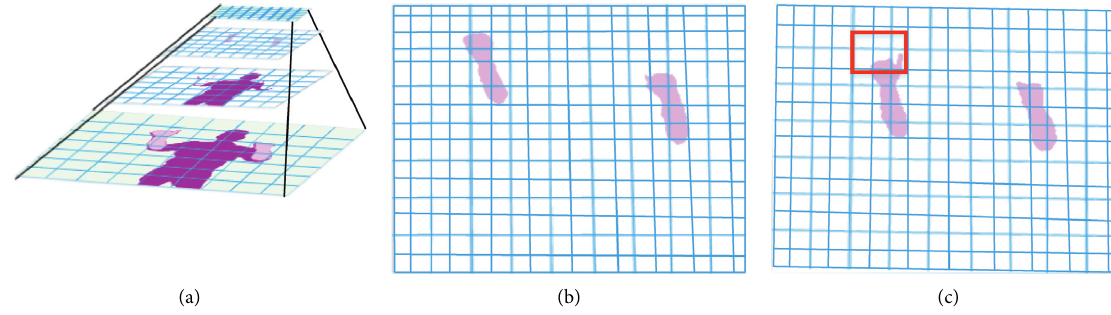
Figure 2: Illustration for the assumption of global nonrigid and local rigid motion: (a) the depth layered image; (b) the layered result of the t th frame k th layer and (c) the layered result of the t +1 th frame k th layer. The block size is 3 ∗